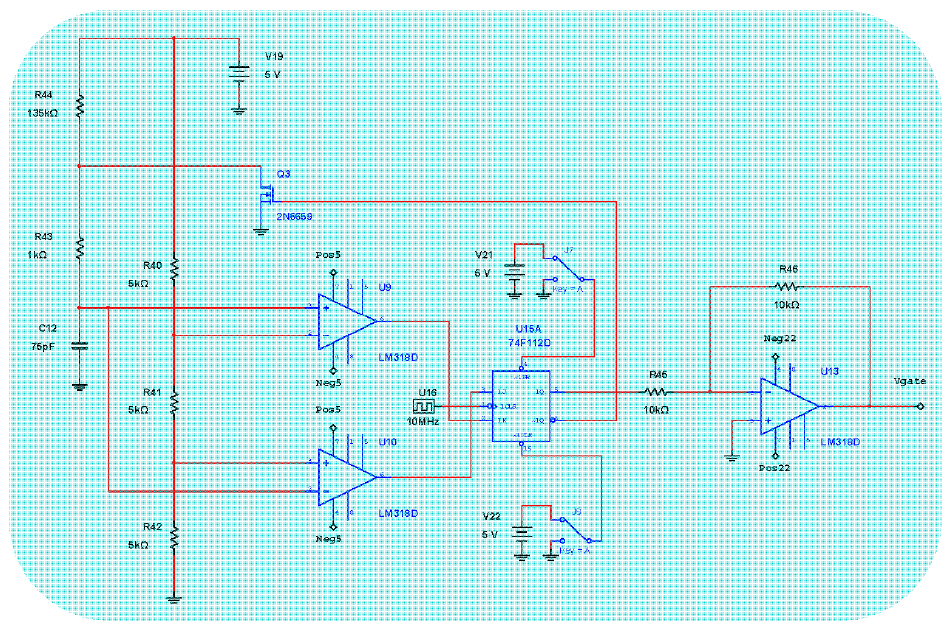
Figure 6. V gate Voltage Signal generator (Astable Pulse Generator + J-K Flip-Flop + Analog Inverter).